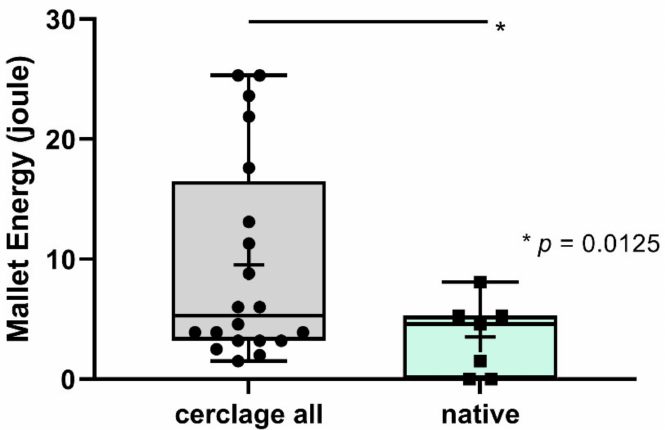
Figure 7. Mallet energy until occurrence of a full fracture was significantly higher for all cerclage groups (cerclage all) compared to the native situation (native). There was no difference between the steel wire and both FiberTape groups (11.4 J vs. 8.6 J, respectively; p = 0.2695) (Figure